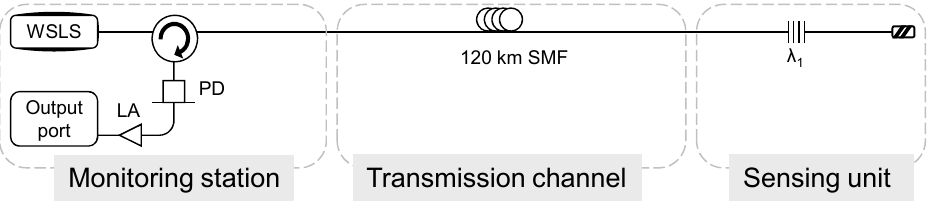
Figure 8. Experimental set-up for the FBG sensor system. PD: photodetector. L.A.: logarithmic amplifier. WSLS: wavelength-swept light source. Adapted from